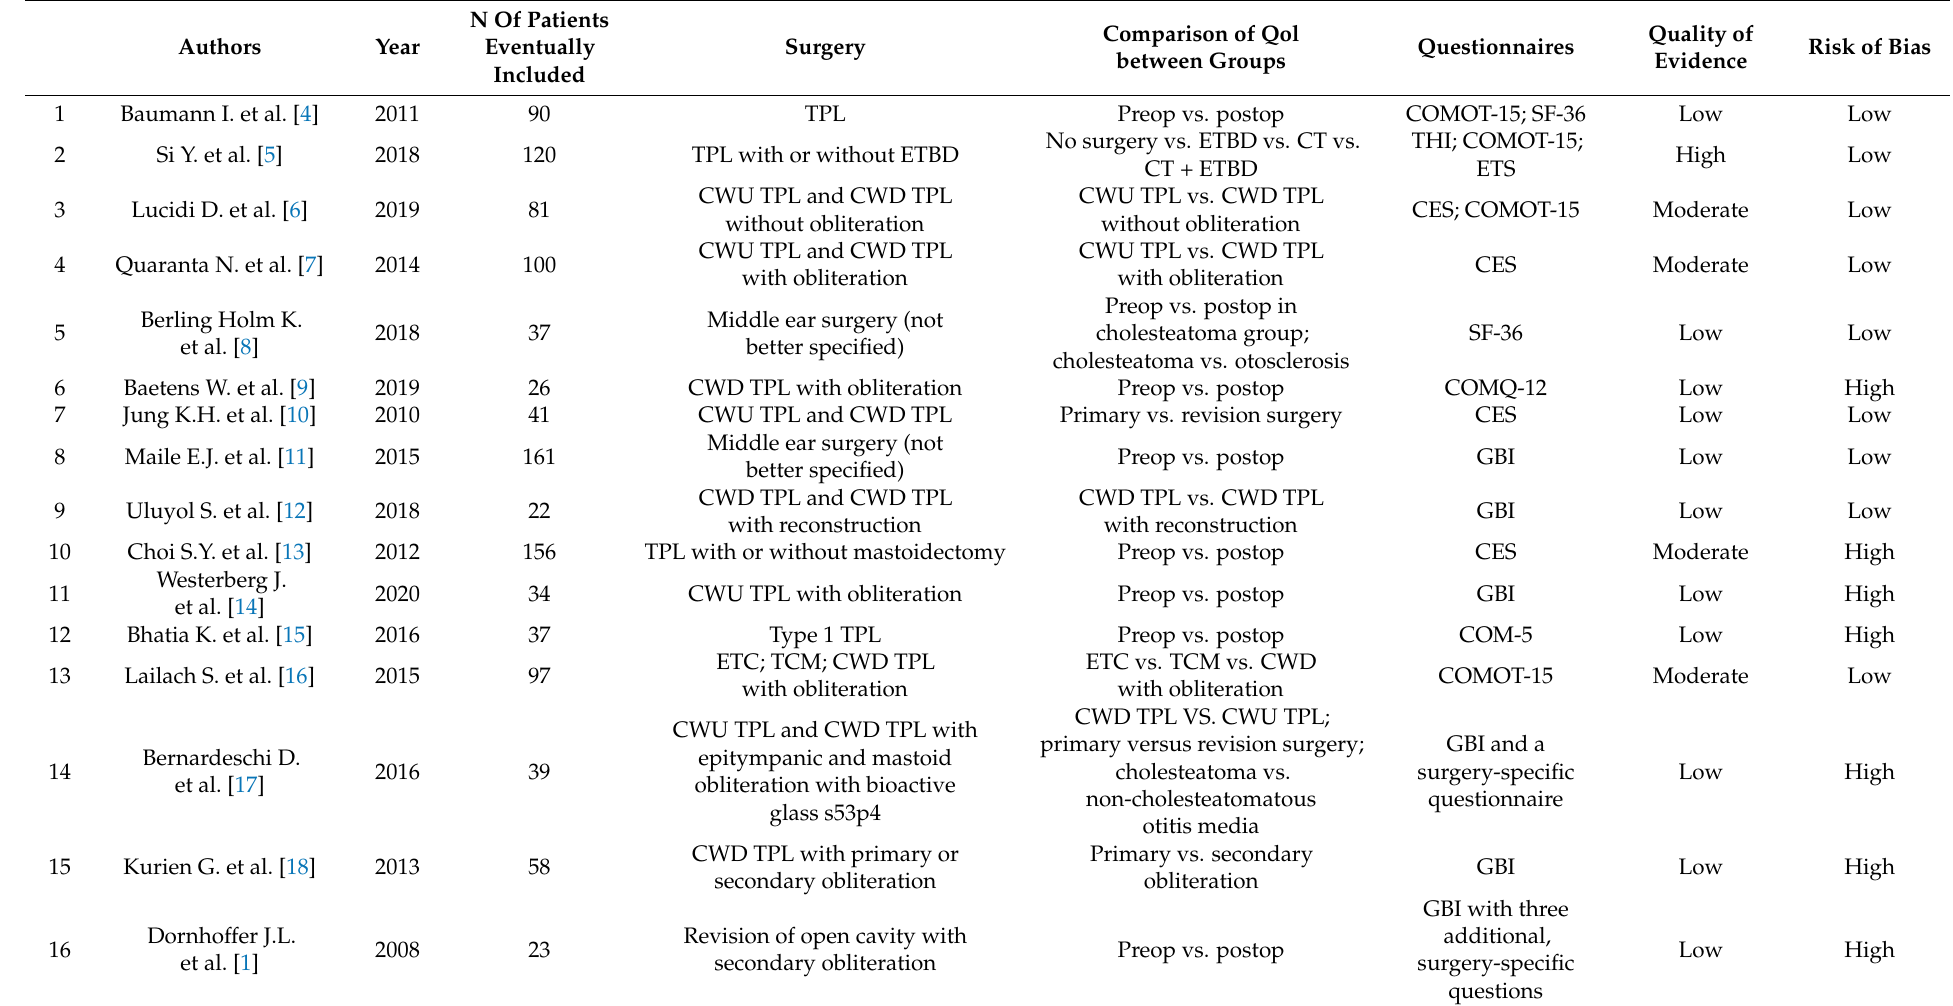
Table 2. Summary of included